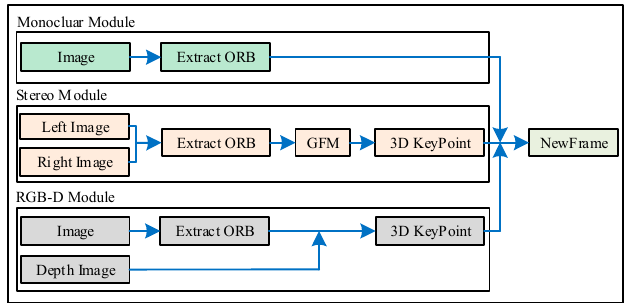
Figure 5. The pipeline shows image frame construction for monocular, stereo, RGB-D cameras. The GMS feature matching algorithm is mainly used in the stereo camera part to improve the matching speed and matching effect.